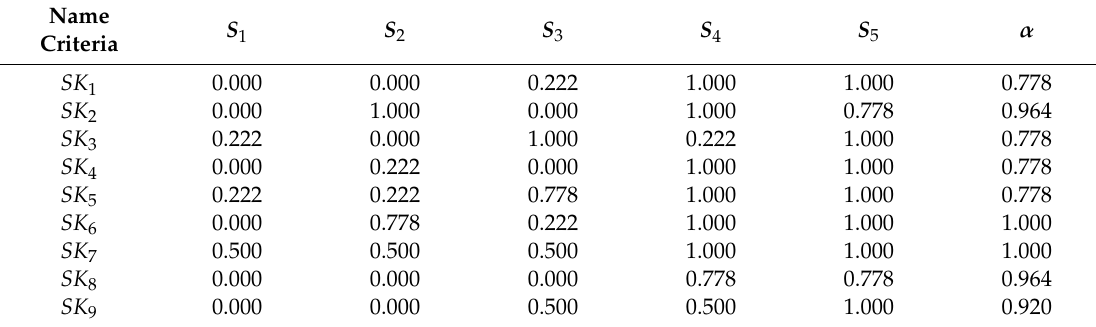
Table 4. Normalized data on the criteria for evaluating environmental start-up